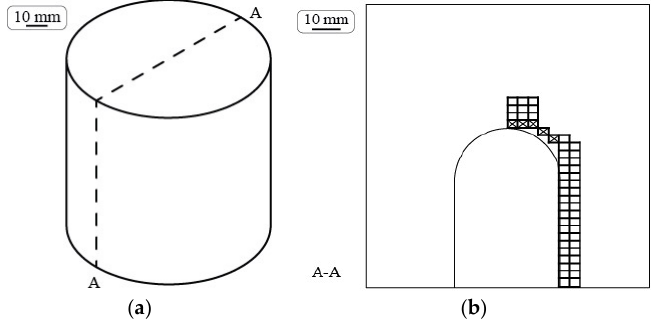
Figure 2. ( a ) Isometric view of the metal expansion penetration (MEP) sample; ( b ) Cross ‐ section view of the MEP sample.